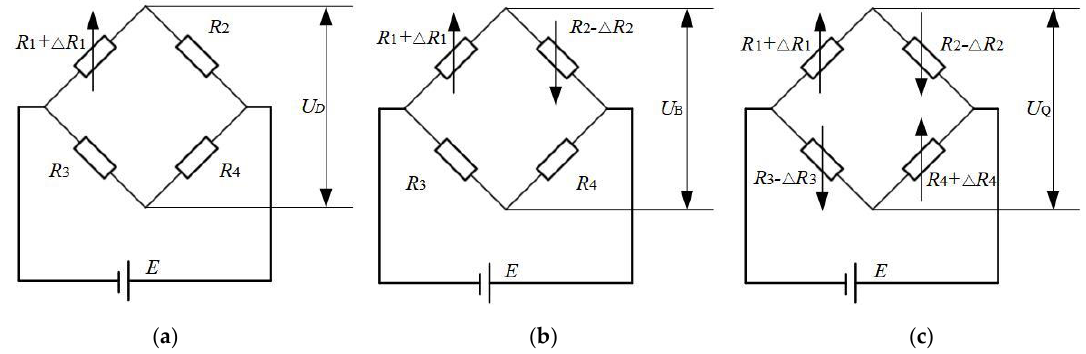
Figure 2. Measuring device equivalent circuit diagram. ( a ) Single bridge circuit; ( b ) Half bridge circuit; ( c ) Full bridge circuit.